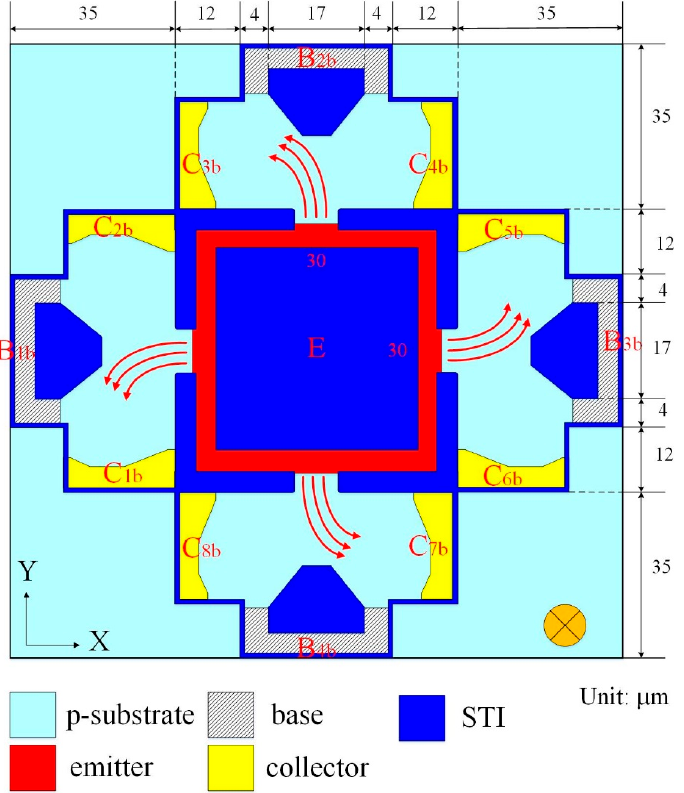
Figure 2. The z-MSE structure, where E is emitter; B 1b , B 2b , B 3b and B 4b are base; C 1b , C 2b , C 3b , C 4b , C 5b , C 6b , C 7b and C 8b are collectors.